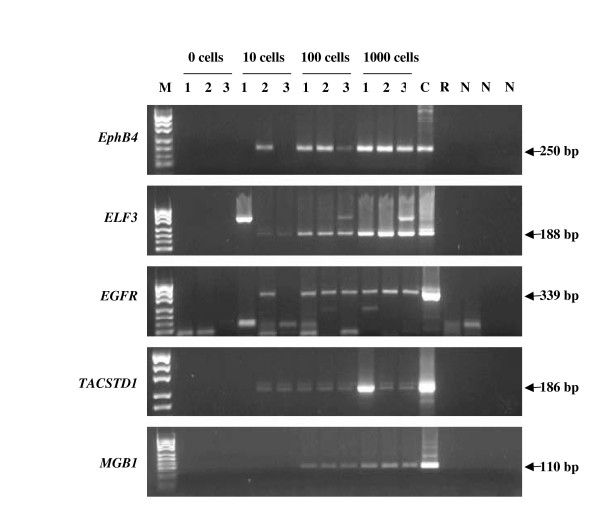
IB RT-PCR sensitivity test on dilutions of MDA-MB-453 in normal blood. Cells were added to 10 mls of normal blood. Lane 1, M = pUC19/HpaII marker. Lanes 2–4, no added cells. Lanes 5–7, 10 added cells. Lanes 8–10, 100 added cells, Lanes 11–13, 1000 added cells. Lane 14, C = cDNA positive control. Lane 15, R = RT negative control. Lanes 16–18, N = PCR negative controls. Product size is shown in base pairs (bp). A genomic DNA band is seen above the RT-PCR band for ELF3. The legend shows cells/10 ml of blood.